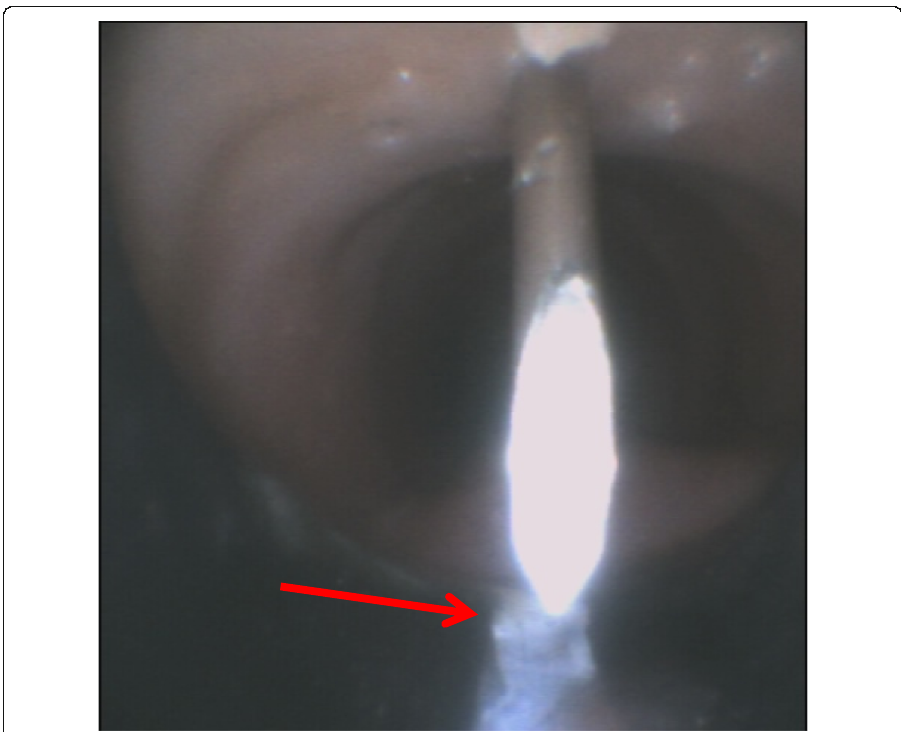
Table 3 Complications of tracheal needle puncture in procedures by all operators Complications Standard ( N = 58) tTNI ( N = 58) Chi-square n % n % p value Anatomical complications* Posterior tracheal wall puncture 6 10.3 0 0 0.0486 ( p < 0.05) Lateral tracheal wall puncture 3 5.2